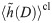
Fitness landscapes and selection strength measured for E. coli F3/pTN001.A. Population growth curves. Green curve is for −Sm condition, and red for +Sm condition (the color correspondence is the same for all subsequent panels). Relative population size on the y-axis is the number of cells at each time point normalized by the number of cells at t = 0 min. The error bars in all panels are the standard deviations of three independent experiments. Growth rate difference became apparent only after t = 200 min. Hence, we set t0 = 200 min and t1 = 400 min in the following analyses. The results with t0 = 0 min and t1 = 200 min are shown in S6 Fig. The numbers of cells at times t0 and t1, which specify the number of cell lineages used in the analysis, are given in S1 Table. B-D. Comparison of population growth rate Λ (B), chronological mean lineage fitness 〈h˜(D)〉cl (C), and selection strength for division count S[D] (D), between −Sm and +Sm conditions. p-values by t-test are 0.013, 0.010, and 0.529, respectively (n = 3). E-G. Fitness landscapes h(x) (upper panels) and chronological distributions Pcl(x) (lower panels) for elongation rate λ¯τ (E), protein production rate p¯τ (F), and protein concentration c¯τ (G). The fitness landscapes for elongation rate and protein production rate were barely distinguishable between −Sm and +Sm conditions, whereas that for protein concentration shows a slight downshift in +Sm condition. In contrast, shift of chronological distributions was observed for elongation rate and protein production rate, but not for protein concentration. H. Selection strengths. We compared selection strengths λτ¯, p¯τ, and c¯τ between −Sm and +Sm conditions, finding a statistically significant difference only for p¯τ (p < 0.05). The p-values are 0.34 for λ¯τ, 0.044 for p¯τ, and 0.58 for c¯τ, respectively (n = 3). I. Relative selection strengths. Again, the difference is statistically significant only for p¯τ (p < 0.05). The p-values are 0.21 for λ¯τ, 0.024 for p¯τ, and 0.14 for c¯τ, respectively (n = 3). J. Relationship between relative selection strength and squared correlation coefficient between h˜(D) and h(x), where x=λ¯τ, p¯τ, or c¯τ. The correlation coefficients were evaluated by both chronological and retrospective probabilities.